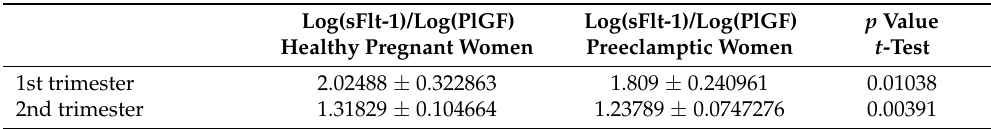
Table 3. Evaluation of the Log (sFlt-1)/Log (PlGF) ratio in healthy pregnant and preeclamptic women at each trimester of